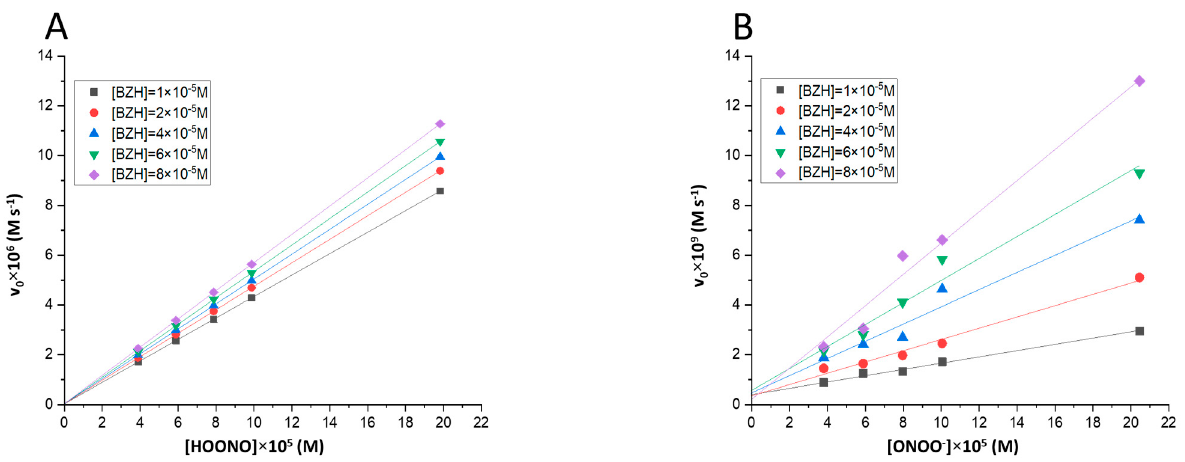
Figure 3. Influence of peroxynitrite concentration on the initial reaction rate. Experimental conditions: I = 0.1 M, T = 25 °C, ( A ) pH = 2, ( B ) pH= 11.2. At pH= 2